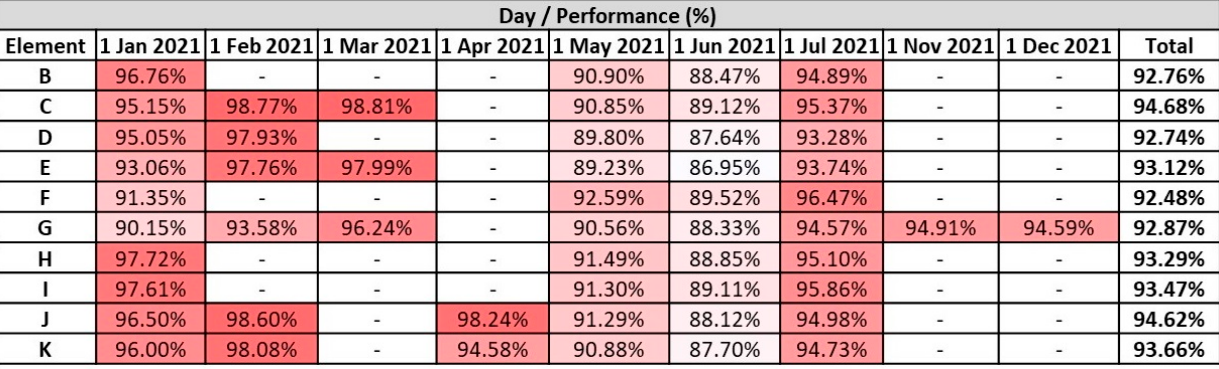
Figure 17. Solar field performance heat map (using red color conditional formatting) under optimal conditions over the evaluation period.